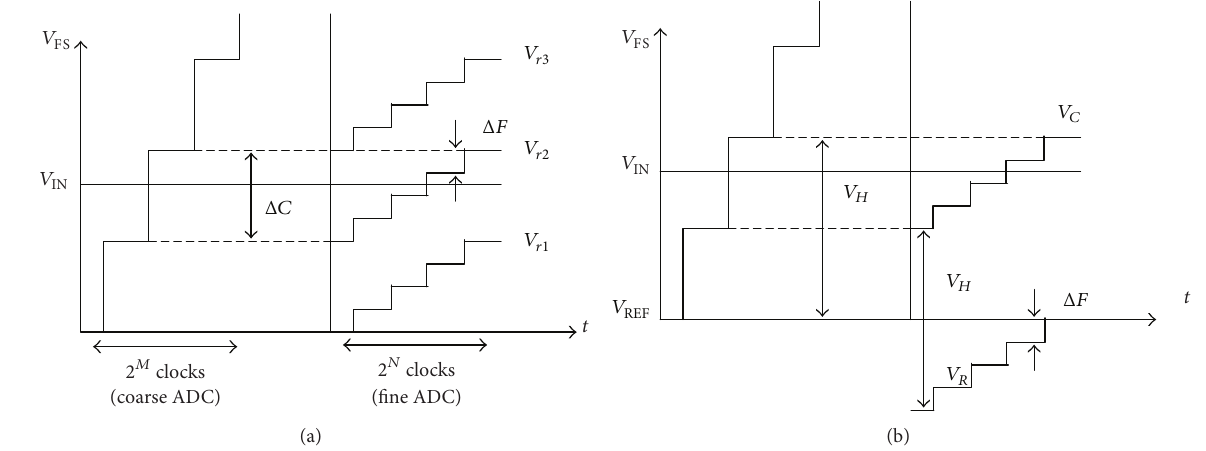
Figure 1: The principle of the conventional two-step single slope ADC [7].